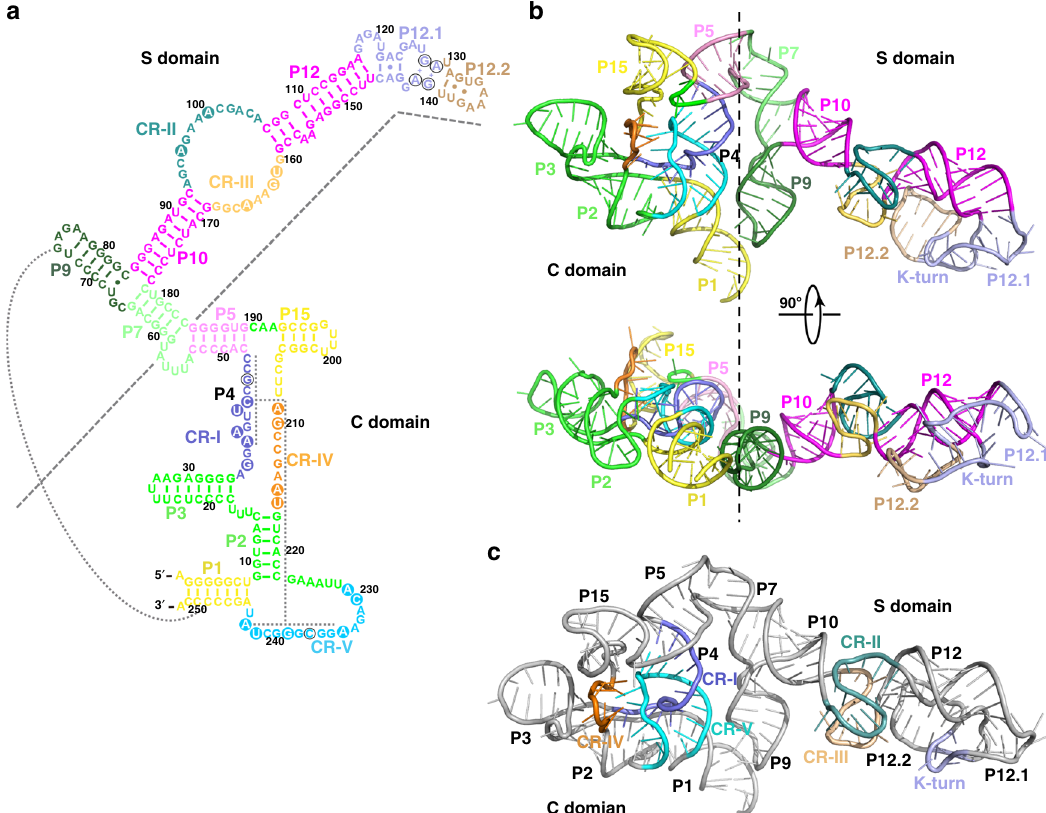
Fig. 3 Structure of the M. jannaschii RPR. a Secondary structure of RPR. Structural elements are colored to match their labels. The conserved regions of RPR (CR-I to CR-V) are colored in slate, deepteal, yelloworange, orange and cyan, respectively. The conserved P4 stem is denoted with dotted line. Dotted line between stem P1 and P9 indicates long-range RNA-RNA interaction. b Two orthogonal views of the overall structure of RPR. RPR is colored as in ( a ). c Overall structure of the RPR. The pseudoknot and the T-loop regions locate in the C and S domains of RPR, respectively. CR-I to CR-V are colored as in ( a